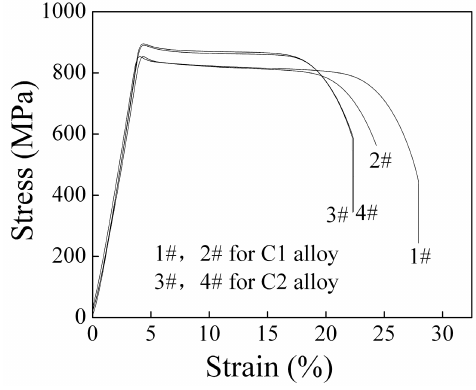
Figure 6. Tensile stress-strain curves of C1 and C2 alloys solution-treated at 800 °C for 1 h. Table 2. Tensile properties of both alloys solution treated at 800 °C for 1 h.